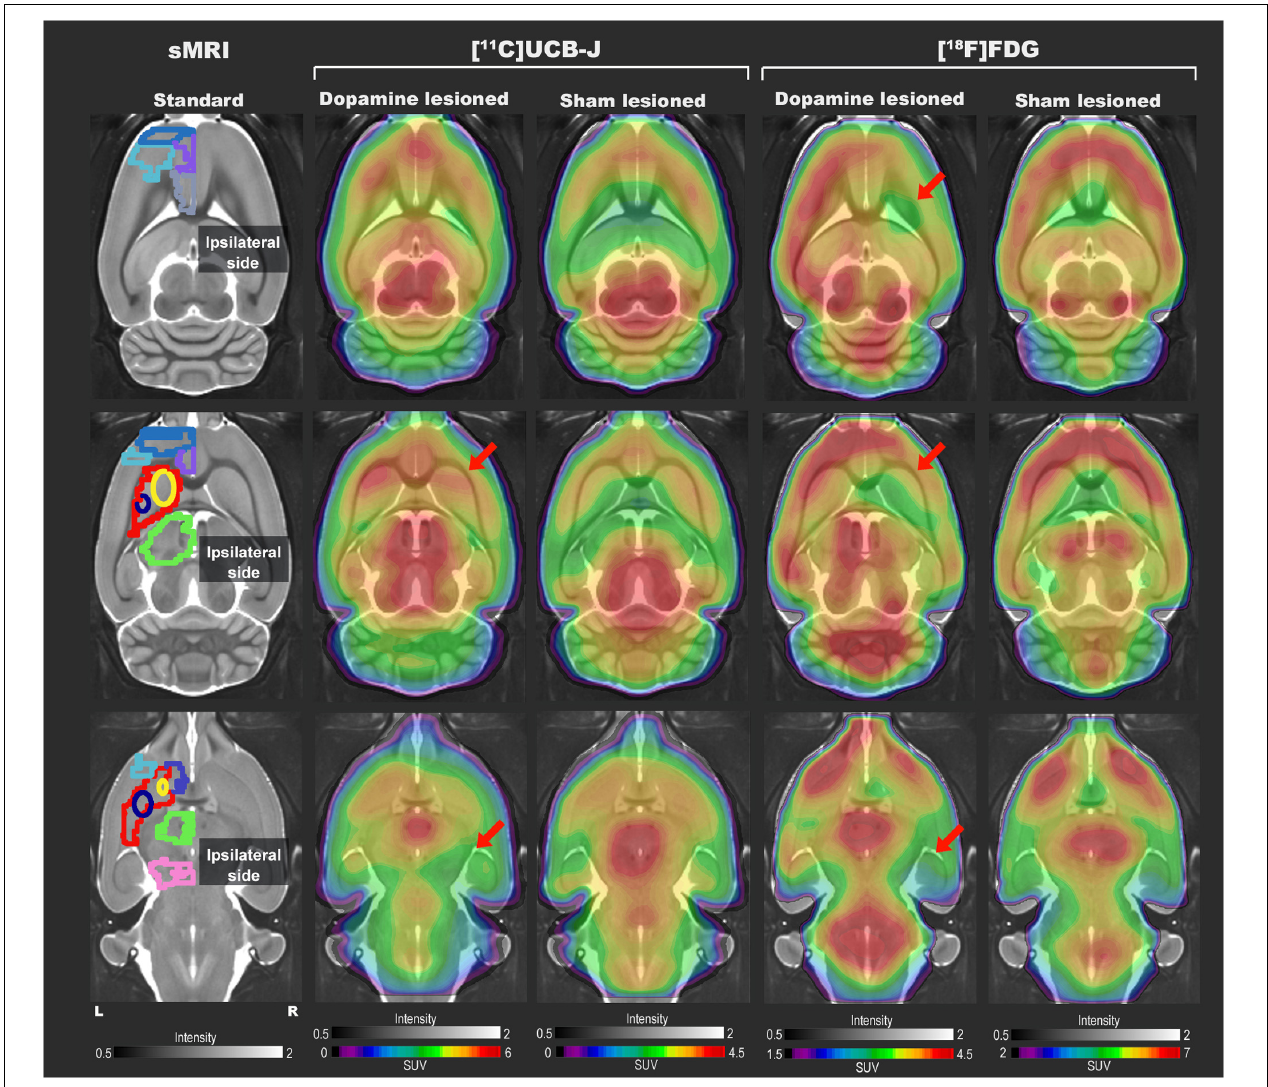
FIGURE 3 | Representative [ 11 C]UCB-J and [ 18 F]FDG PET SUV horizontal brain slices from a dopamine and a sham lesioned rat. Standard structural MRI (for illustrative purposes) slices show the selected volumes of interest in one hemisphere; mPFC (medium blue), OFC (purple), motor cortex (light blue), ACC (grey), striatum (red), dorsomedial striatum (yellow), dorsolateral striatum (navy blue), thalamus (green), NAc (dark blue), and ventral midbrain (pink). For [ 11 C]UCB-J, the SUV image represents the sum of 15–60 min; for [ 18 F]FDG, it is the sum of all 45 min. The red arrow shows decreased tracer uptake in dopamine lesioned